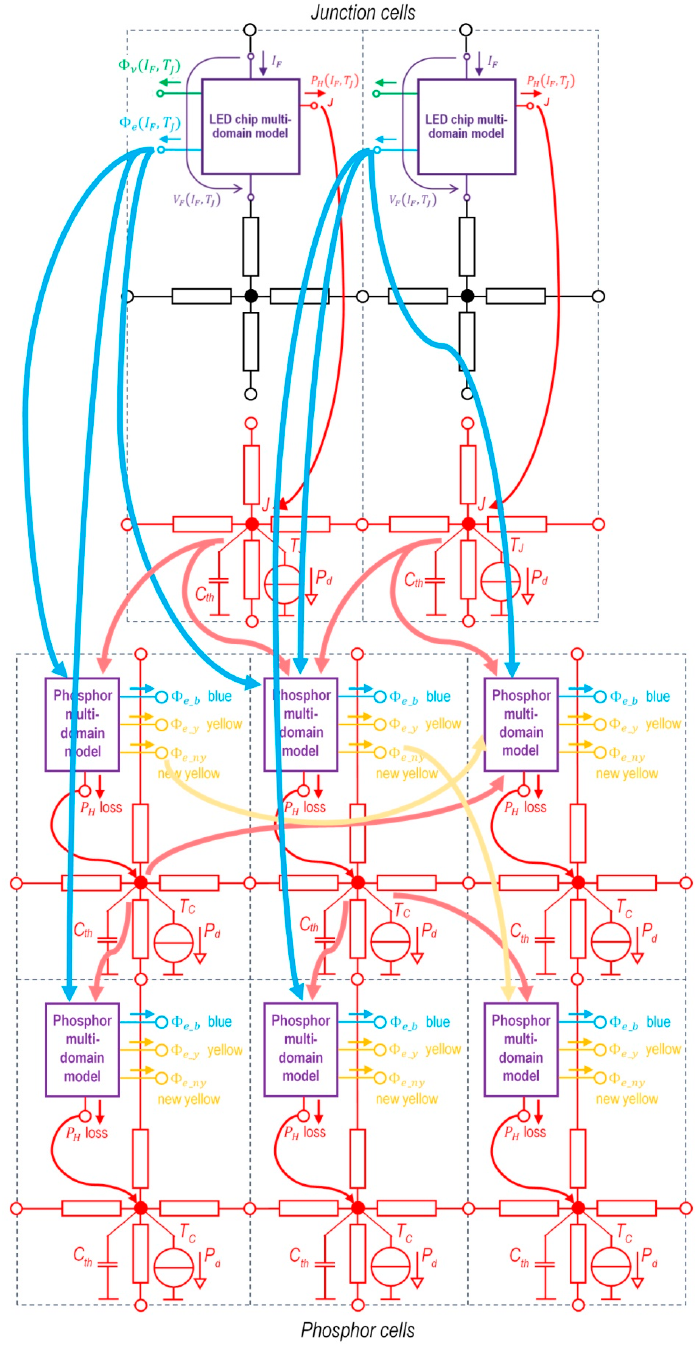
Figure 13. Part of the realization of the overall scheme of Figure 3 within our Finite Volumes Method (FVM) numerical solver: The multi-domain FVM cell models depicted in 2D—black circuit elements represent electrical connections, red circuit elements represent mesh grid cells of the thermal subsystem. The mesh grid level multi-domain phosphor model takes local temperature and material parameters, plus the incident blue and yellow light fluxes as input and provides the transmitted blue/yellow light and converted yellow light fluxes as output. (For a detailed explanation of the symbols used in the drawing refer to the main text). For the explanation of symbols used in this figure see the main text and the Appendix.